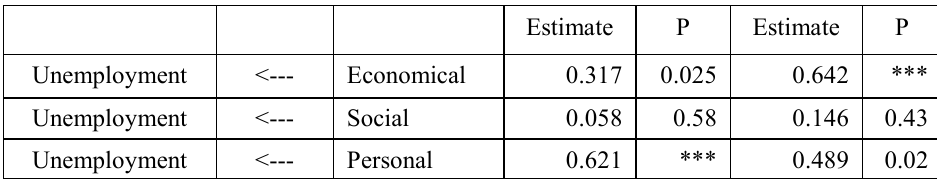
Table 4. Differences between Male and